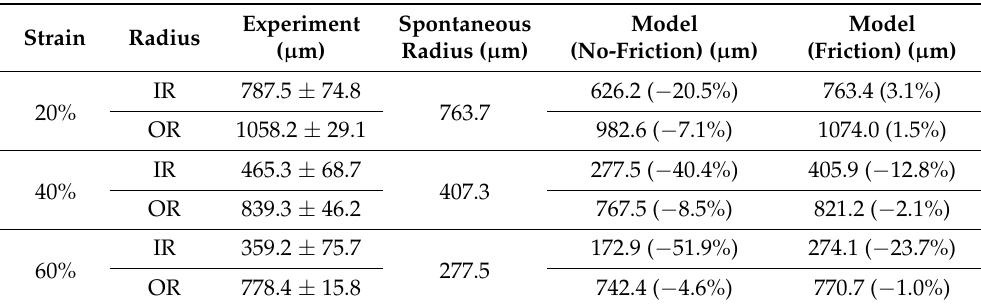
Table 1. Comparison of the inner and outer radii, experimentally analyzed, and their prediction in terms of the spontaneous radius and in the presence/absence of the friction assumption. IR = inner radius; OR = outer radius. N = 5. The percentage difference between our model’s outcomes and the experimental results is reported in the